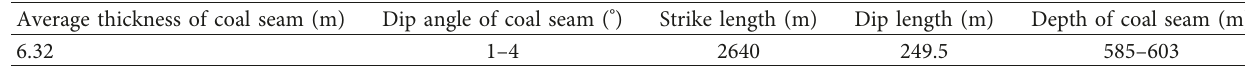
Figure 8: Mechanical response analysis procedure of the buried pipeline. Table 1: Basic conditions of the 14101 working face.